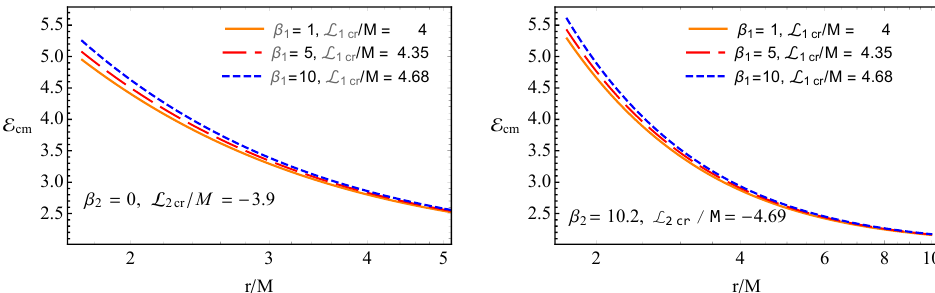
Figure 15. The same figure as Figure 14 but for collisions of two magnetized particles for different values of the GB parameter and the corresponding critic angular